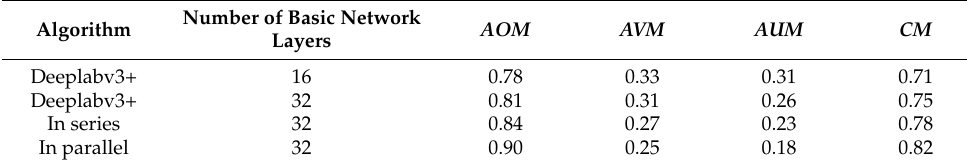
Table 6. Long coastline extraction effect.